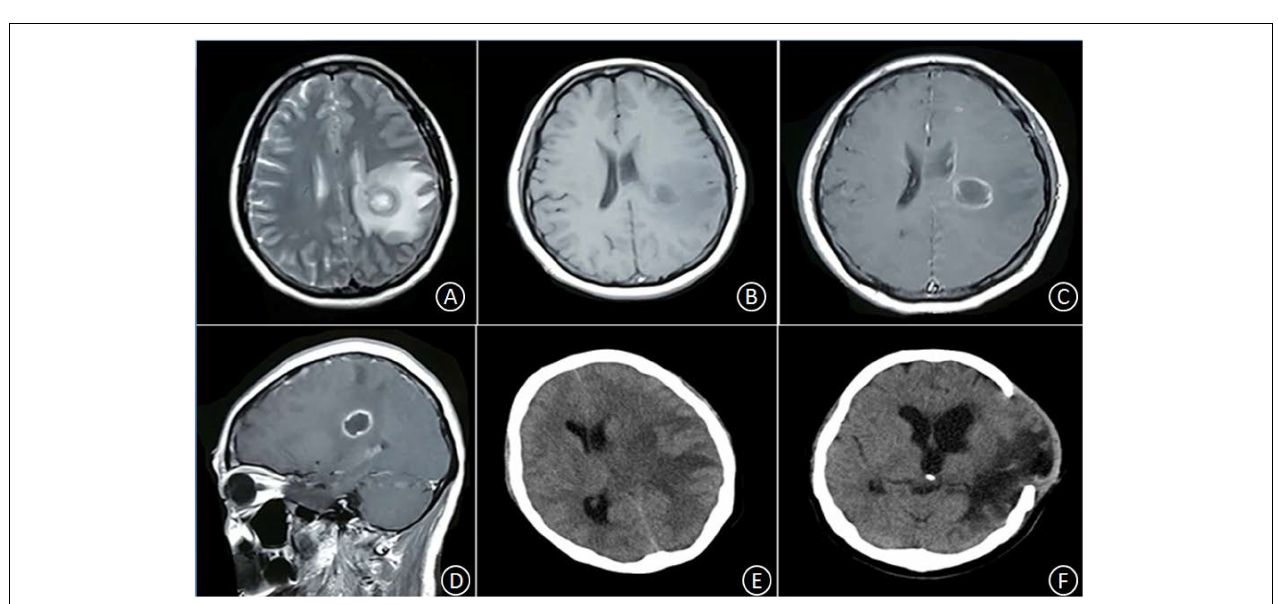
FIGURE 2 | In the left basal ganglia area, an aberrant, circular space-occupying lesion with long T1 and long T2 signal shadows was observed. Its ring wall had relatively even thickness, manifesting as slightly short T1 and T2 signal shadows (A,B) . The lesion-surrounding area contained patches of apparent oedema; the left ventricle displayed slight compression-resulted deformation; and the midline structures displayed minor rightward shift. After enhancement, the ring wall but not the center, exhibited signal intensification (C,D) . Twelve hours after hospitalization, the oedema in the lesion-surrounding area became more pronounced; the ventricle displayed severe compression-resulted deformation; and the midline structures showed clear rightward shift (E) . Five weeks after the operation, the space-occupying lesion disappeared, but the surrounding area still contained large patches and stripes of low-density shadows with blurred boundary; the surrounding brain tissue showed swelling, with outward bulging in few pockets; the left ventricle displayed enlargement; and the midline structures stayed in the middle (F)